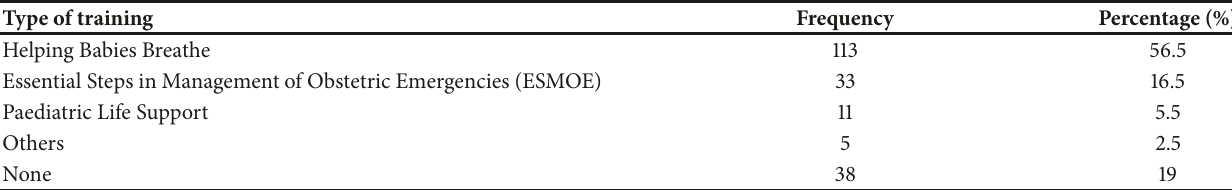
Table 7: Type of training received by participants in neonatal resuscitation.